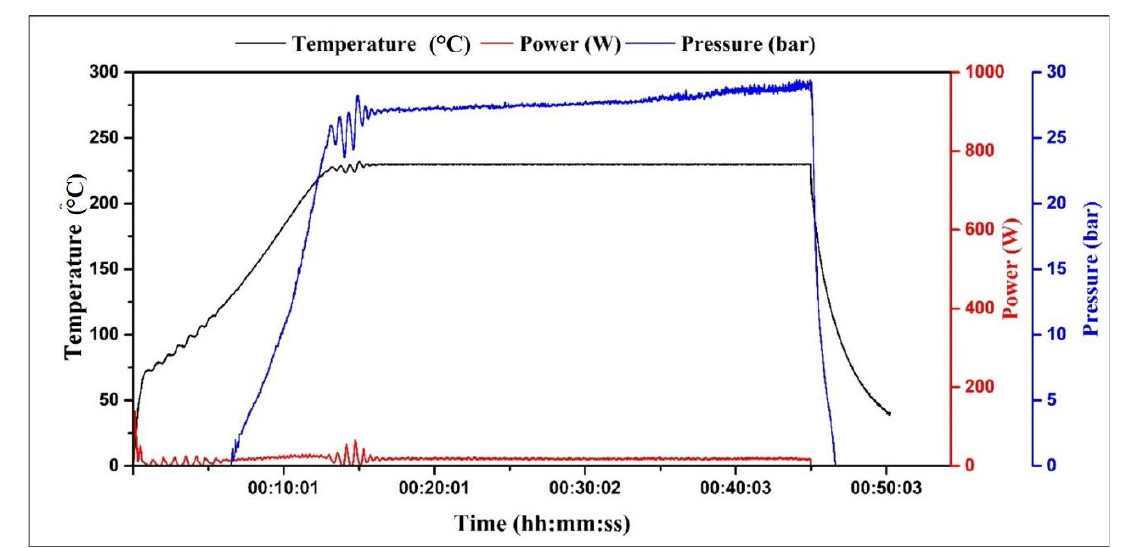
Figure 1. Synthesis of material.